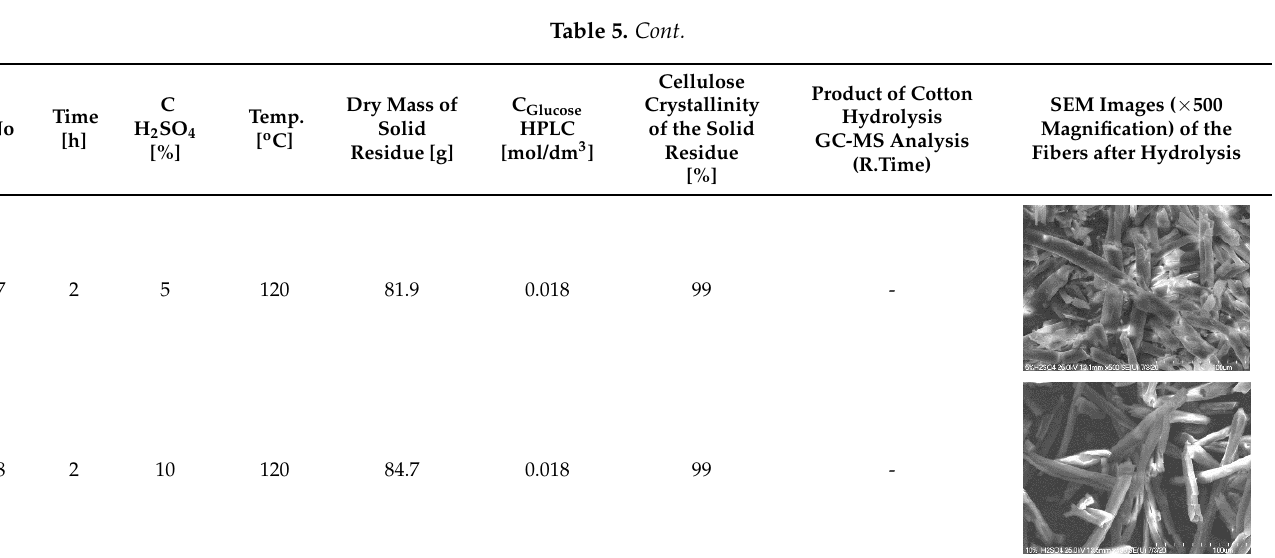
Table 6. Conversion degree of glucose and selectivity to gluconate ions in the reaction of glucose from hydrolysates of cotton in the presence of 5% Pd-1% Au/SiO 2 catalyst. Reaction